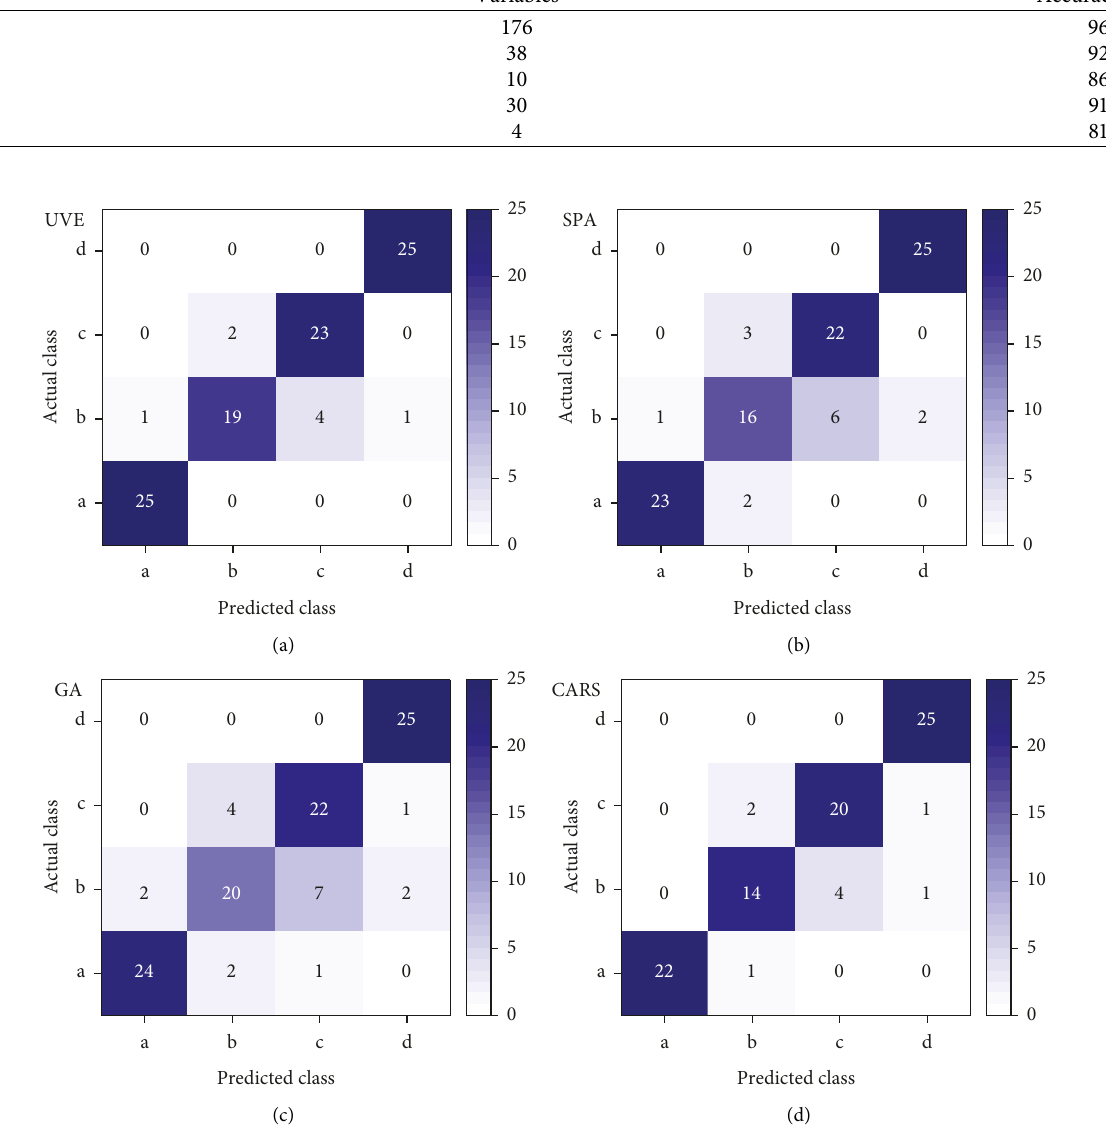
Figure 7: Results of the mixed-spectral-LS-SVM model were optimized by UVE, SPA, CARS, and GA for (a) bruising 6h, (b) bruising 12h, (c) bruising 24h, and (d) bruising